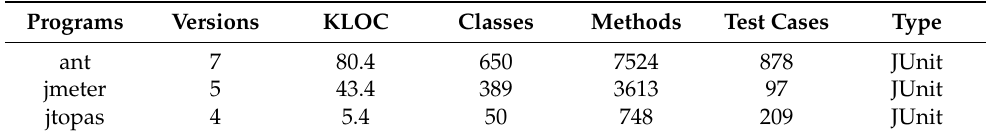
Table 2. Subject Programs.